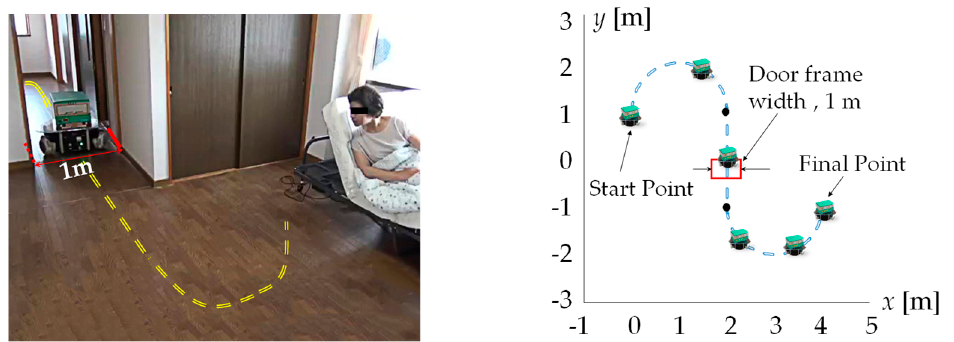
Figure 15. One kind of working path in the actual family environment and its setting in two ‐ dimensional coordinates.